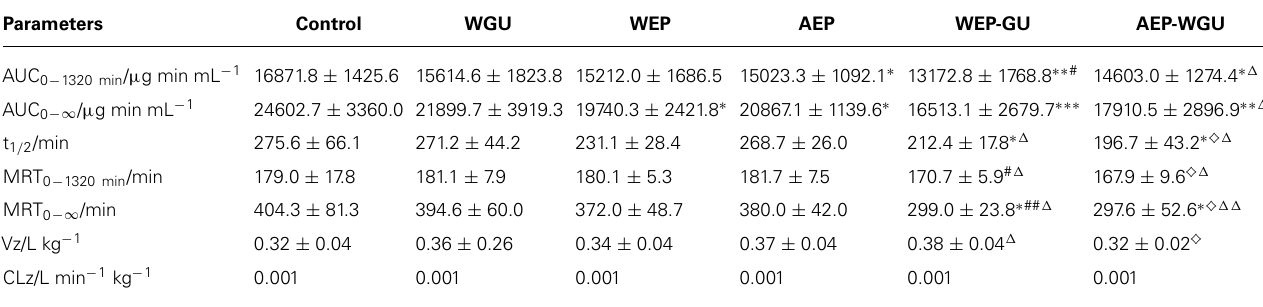
Table 1 | Main pharmacokinetic parameters of tolbutamide in rats ( ¯ x ± s, n = 6). Parameters Control WGU WEP